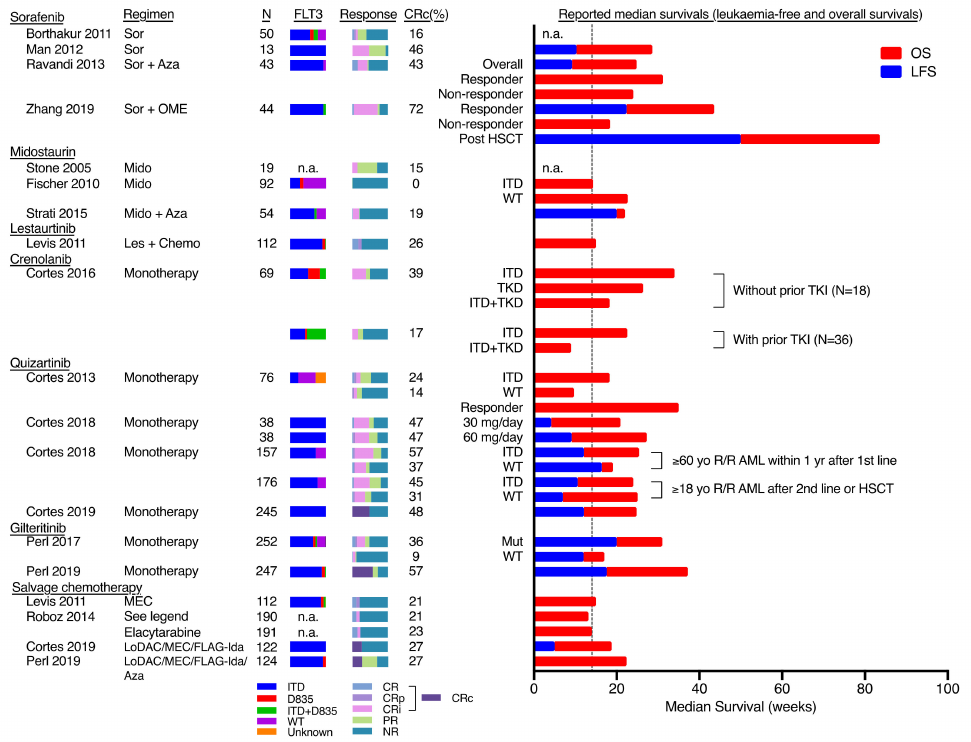
Figure 1. Results of clinical trials involving Fms-Like Tyrosine kinase 3 (FLT3) inhibitors